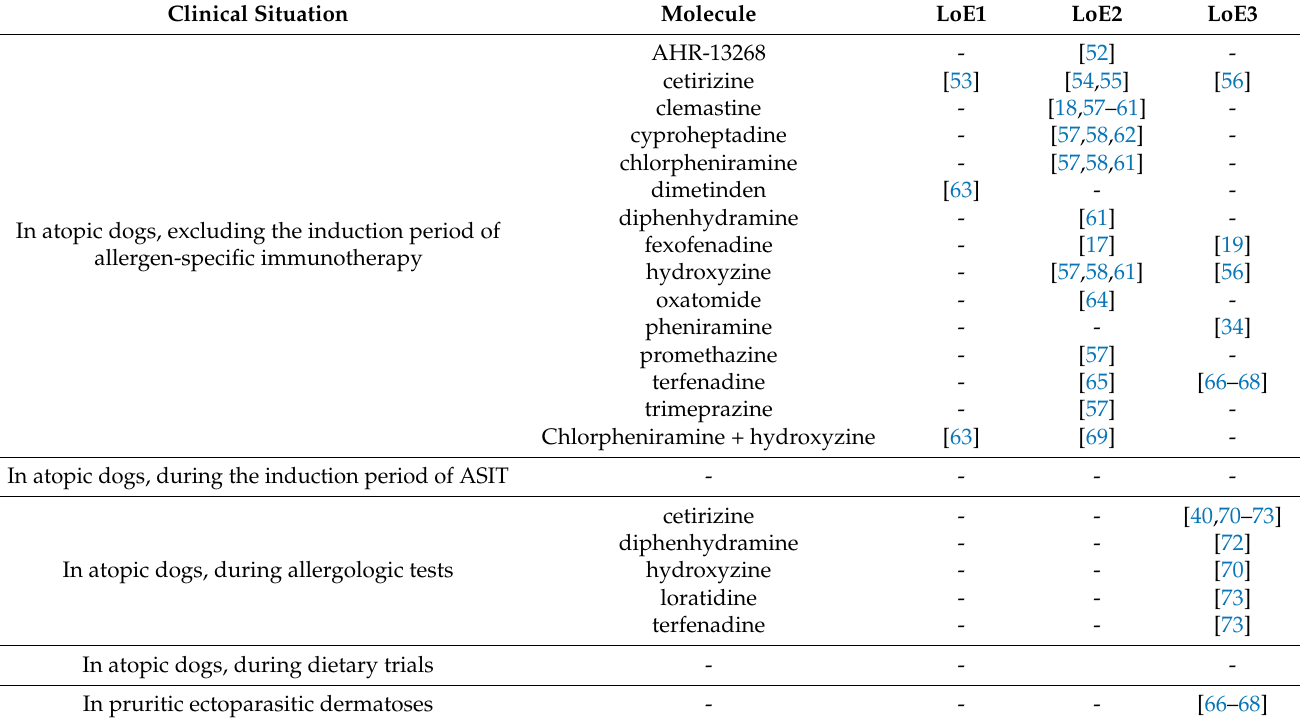
Table 4. Level of evidence (LoE) of individual studies of the use of antihistamines in different clinical